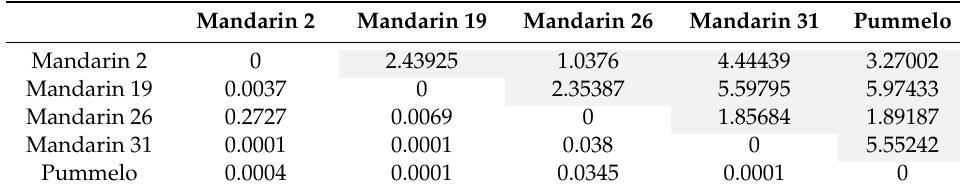
Table 3. Discriminant analysis matrix showing di ff erences in Diaphorina citri probing responses to four Cleopatra Mandarin selections and